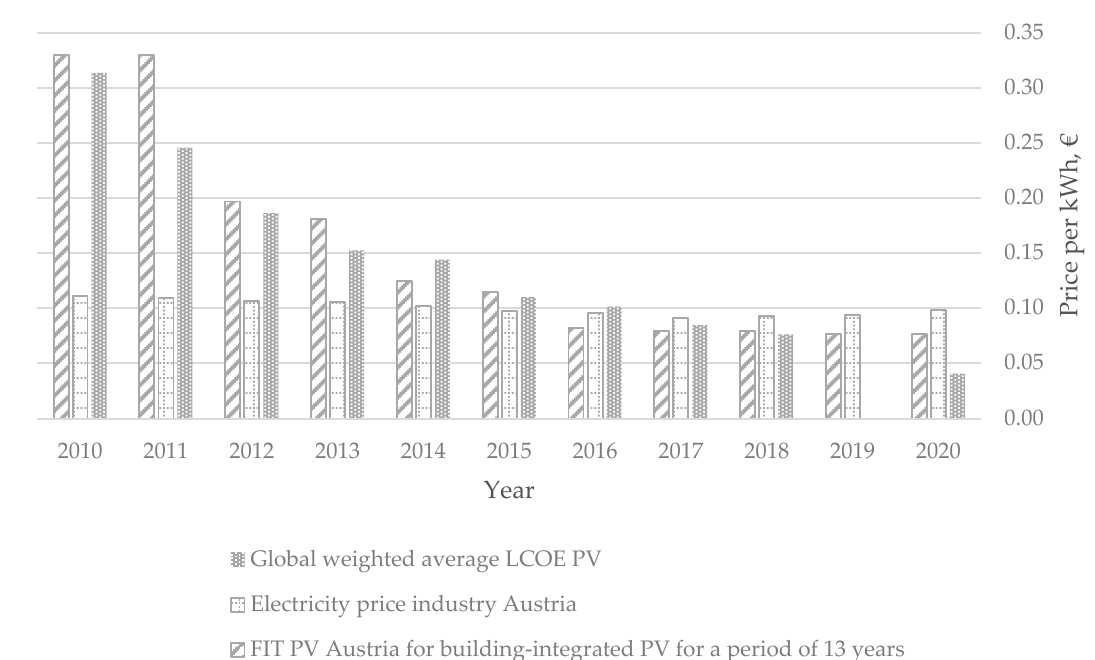
Figure 5. Development of levelized costs of electricity (LCOE), electricity price industry Austria and feed-in-tariffs (FIT) for building-integrated PV in Austria (own illustration based on